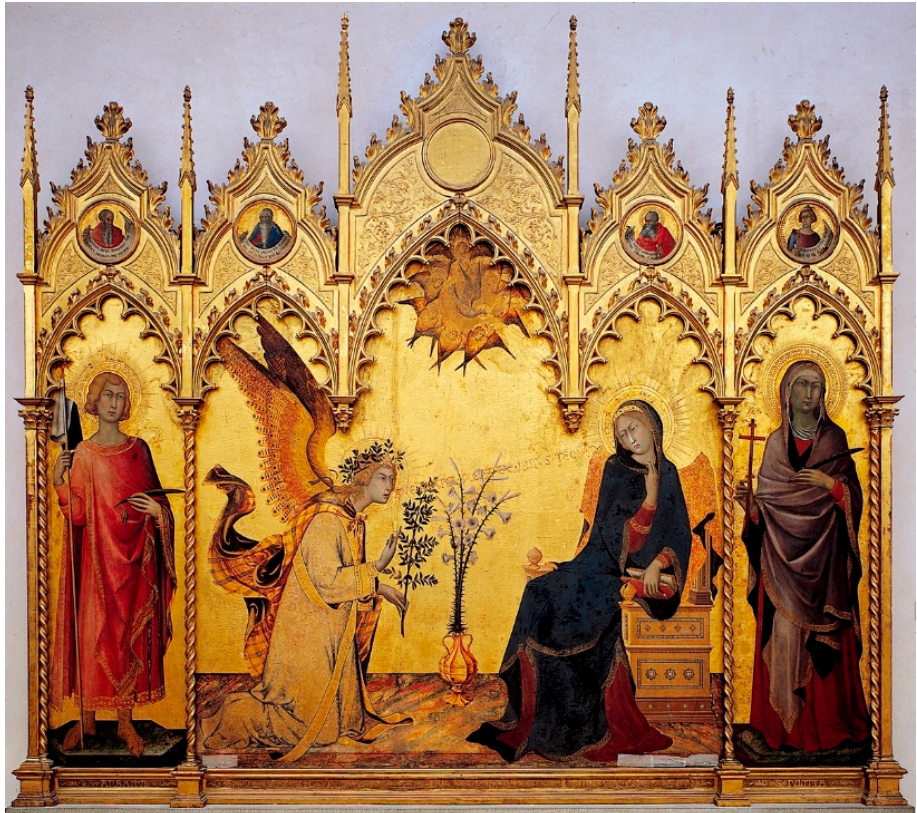
Figure 1. Simone Martini (with Lippo Memmi), L’Annunciazione con i Santi Ansano e Margherita , 1333. Galleria degli Uffizi, Florence.